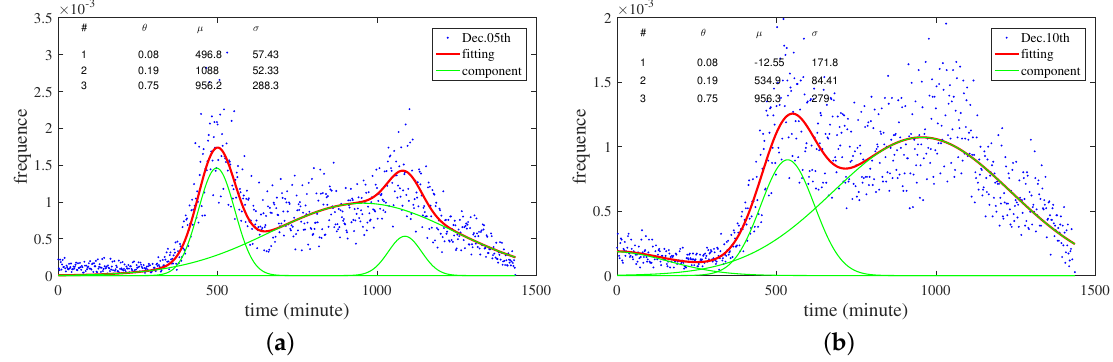
Figure 5. The time distribution of flow on 5 December and 10 December. ( a ) time distribution of flow on 5 December ( b ) time distribution of flow on 10 December. The blue dots in the figure represent the proportion of flow per minute, and the time distribution is fitted by the 3rd-order Gaussian mixture model in the one-dimensional space. The goodness of fit for December 05 is 0.7687, and the goodness of fit for 10 December is 0.7684. The green lines represent components of the Gaussian mixture model. The model parameters are shown in the upper left corner of each